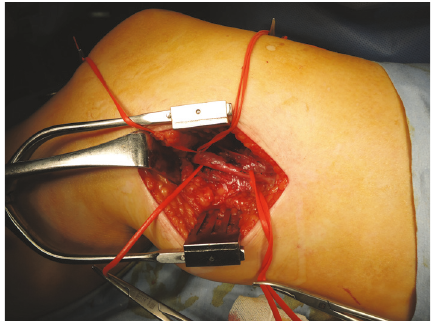
Figure 3: The circumferential cystic enlargement of popliteal